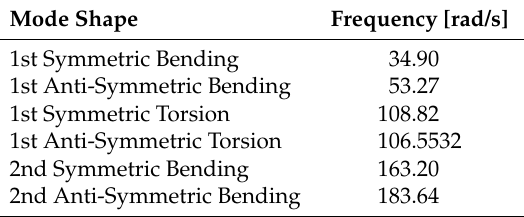
Figure 10. Finite element representation of the Mini MUTT aircraft [24]. Table 2. Natural frequencies from the finite element model ( µ = 1).